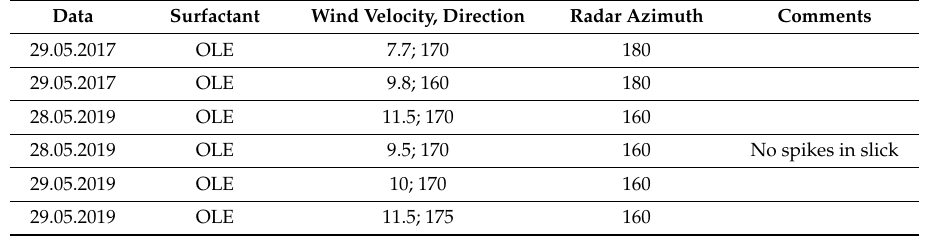
Table 1. Observation of film slicks.